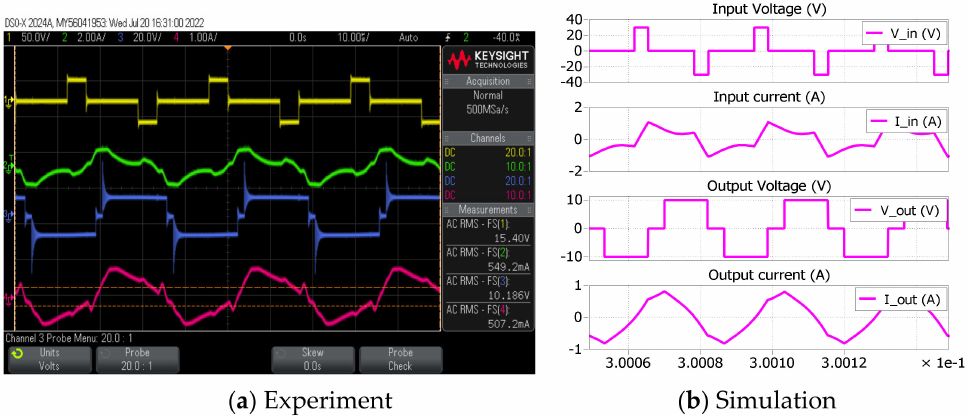
Figure 20. Inverter/rectifier AC voltage and current waveforms at Vo = 10 V, R ac = 38 Ω with R dc = 56 Ω connected.